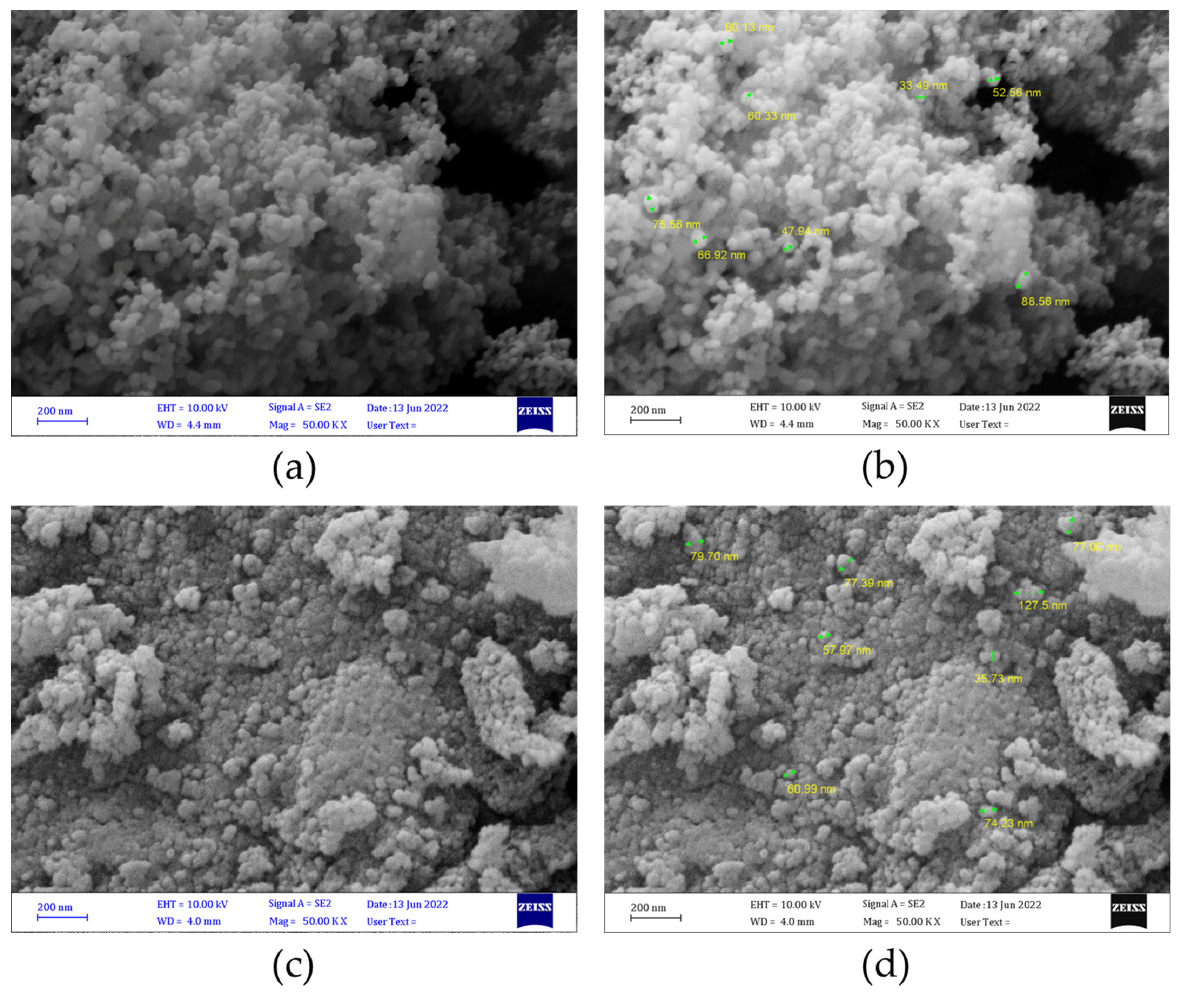
Figure 3. Scanning electron micrographs of TiO 2 NPs ( a , b ) and SiO 2 NPs ( c , d ). ( b ) and ( d ) display measurements of TiO 2 NPs and SiO 2 NPs, respectively.